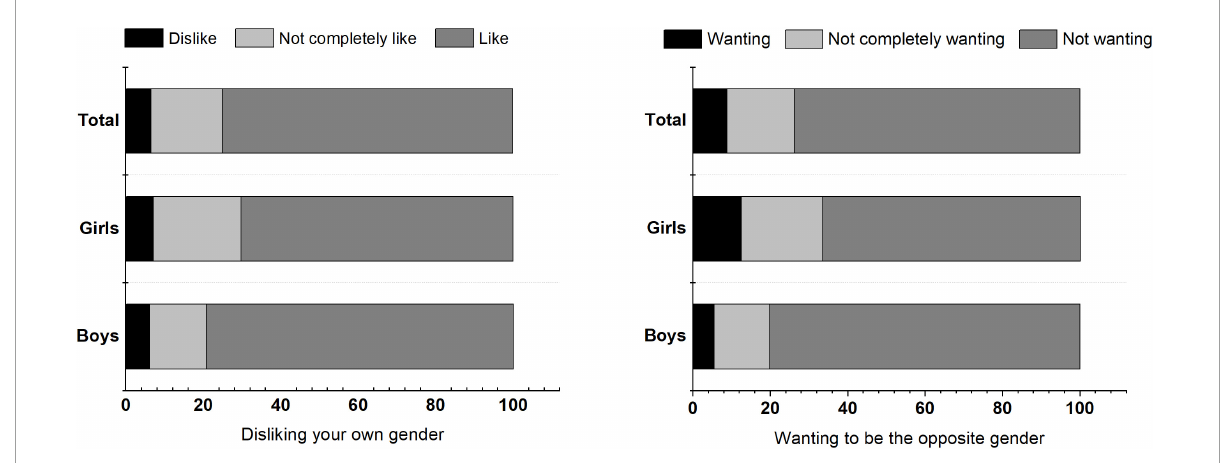
FIGURE1 Proportion of disliking your own gender and wanting to be the opposite gender among children and